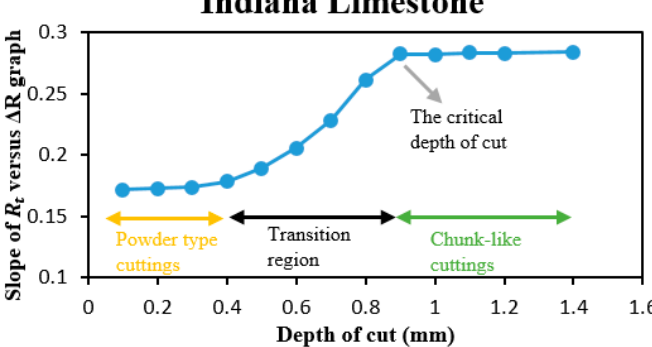
Figure 22. Variation of R t versus ∆ R graph’s slope versus DOC for Indiana limestone.